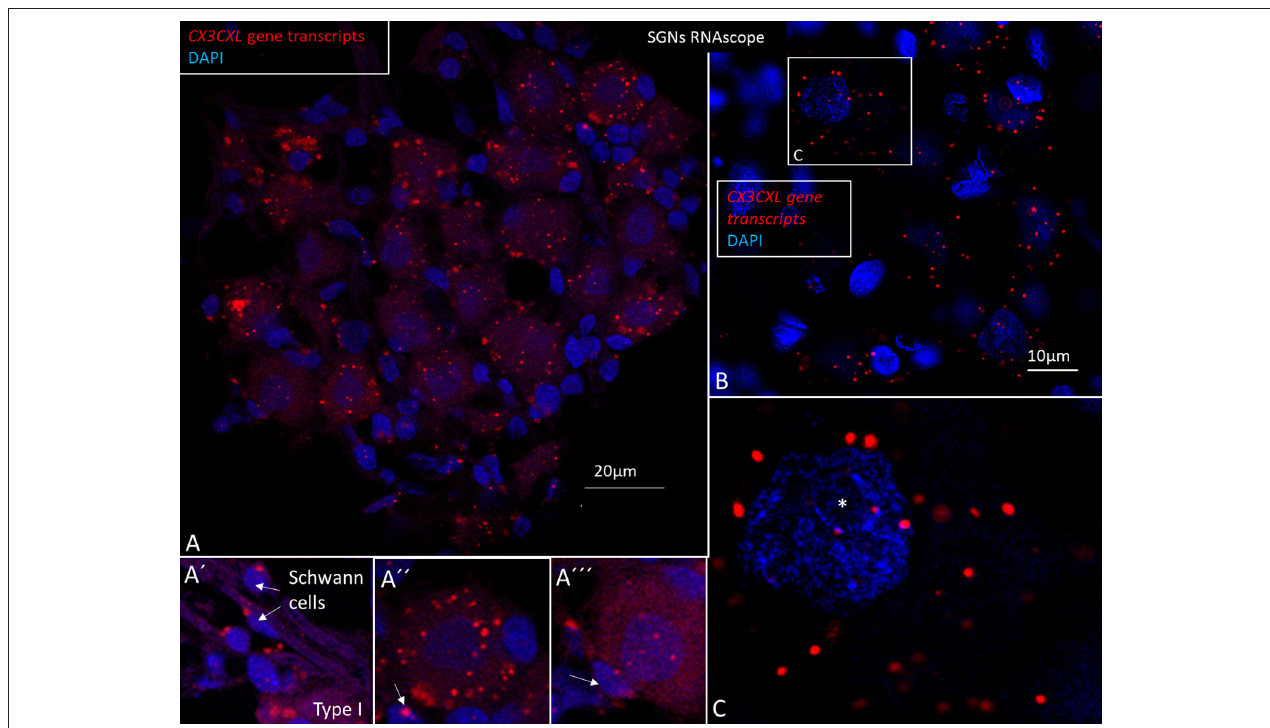
FIGURE 10 | (A–C) SR-SIM and RNA-scope demonstrating CX3CL1 gene transcripts in the human spiral ganglion. Each red punctum represents a single target molecule. Genes are mostly located in the cytoplasm of the type I ganglion cell bodies. Few puncta can also be observed in the axonal Schwann cells (A ′ ) and